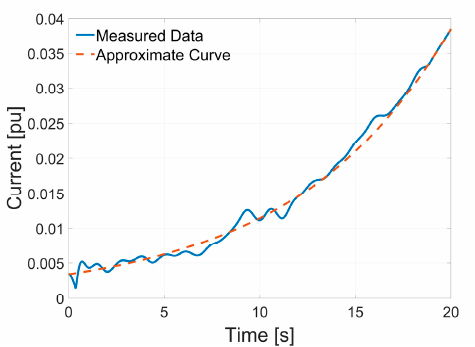
i ′ spectrum in the frequency Figure 12. DC range (0–100) Hz and configuration CD.